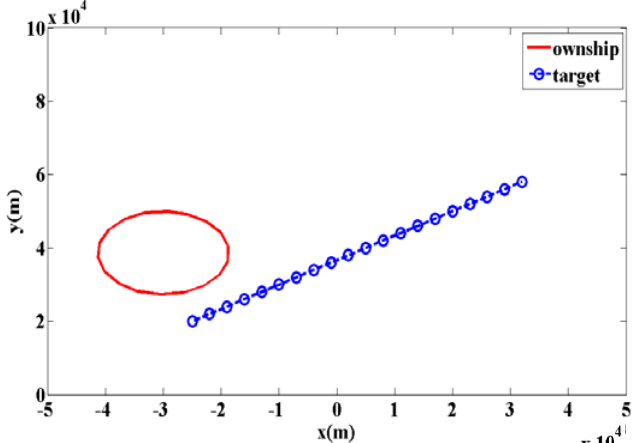
Figure 3. Bearing-only tracking